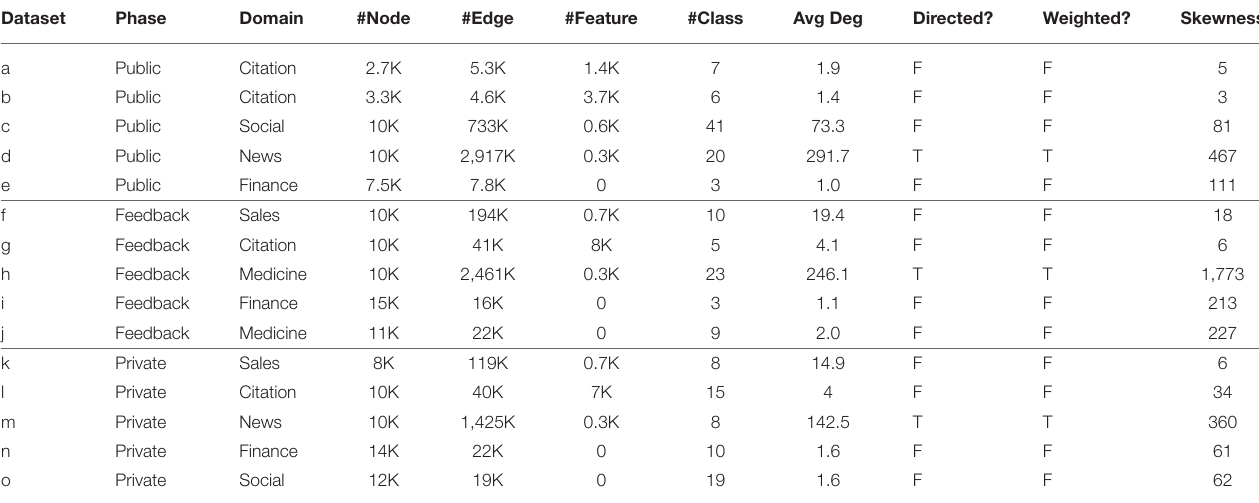
TABLE 2 | Statistics of all